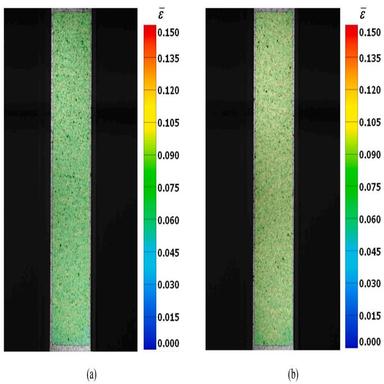
Equivalent strain distribution in the gauge area of uniaxial tensile specimens for pre-tensile strains of (a) 0.079 and (b) 0.093.